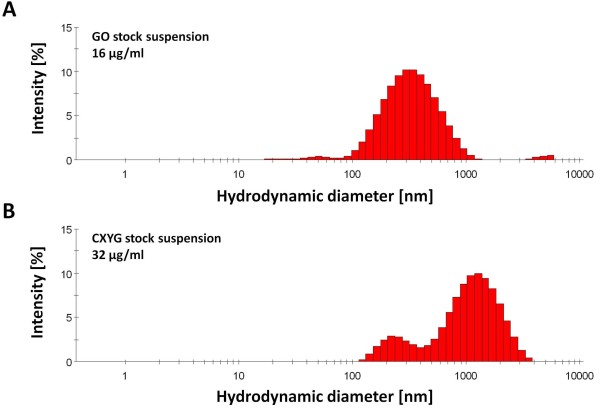
Size distribution of GO and CXYG in stock suspensions determined by means of DLS. GO (A) and CXYG (B) stock suspensions diluted to concentrations of 16 and 32 μg/ml, respectively, were analyzed by means of DLS. The graphs show the average hydrodynamic size distribution by intensity of at least four measurements consecutively conducted on each sample.